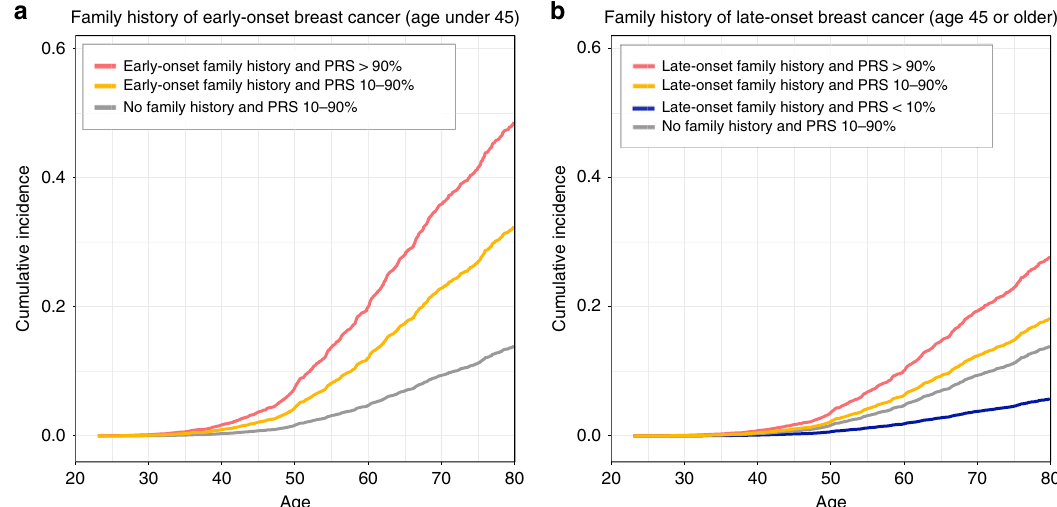
Fig. 3 Impact of the polygenic risk score (PRS) in estimating the breast cancer risk of women with a fi rst-degree relative diagnosed with breast cancer. a Shows the impact of family history of early-onset breast cancer, and b the impact of family history of late-onset breast cancer. Adjusted survival curves based on Cox proportional hazards models. Risk estimated in 7715 mother – daughter pairs and 12,086 full sibling-pairs (sisters). The pairs of fi rst-degree relatives were inferred with KING by a kinship coef fi cient ranging between 0.177 and 0.354 (inference based on 57 K unlinked variants). Due to the sample size, we were unable to assess impact of a low PRS (<10th percentile) with early-onset family